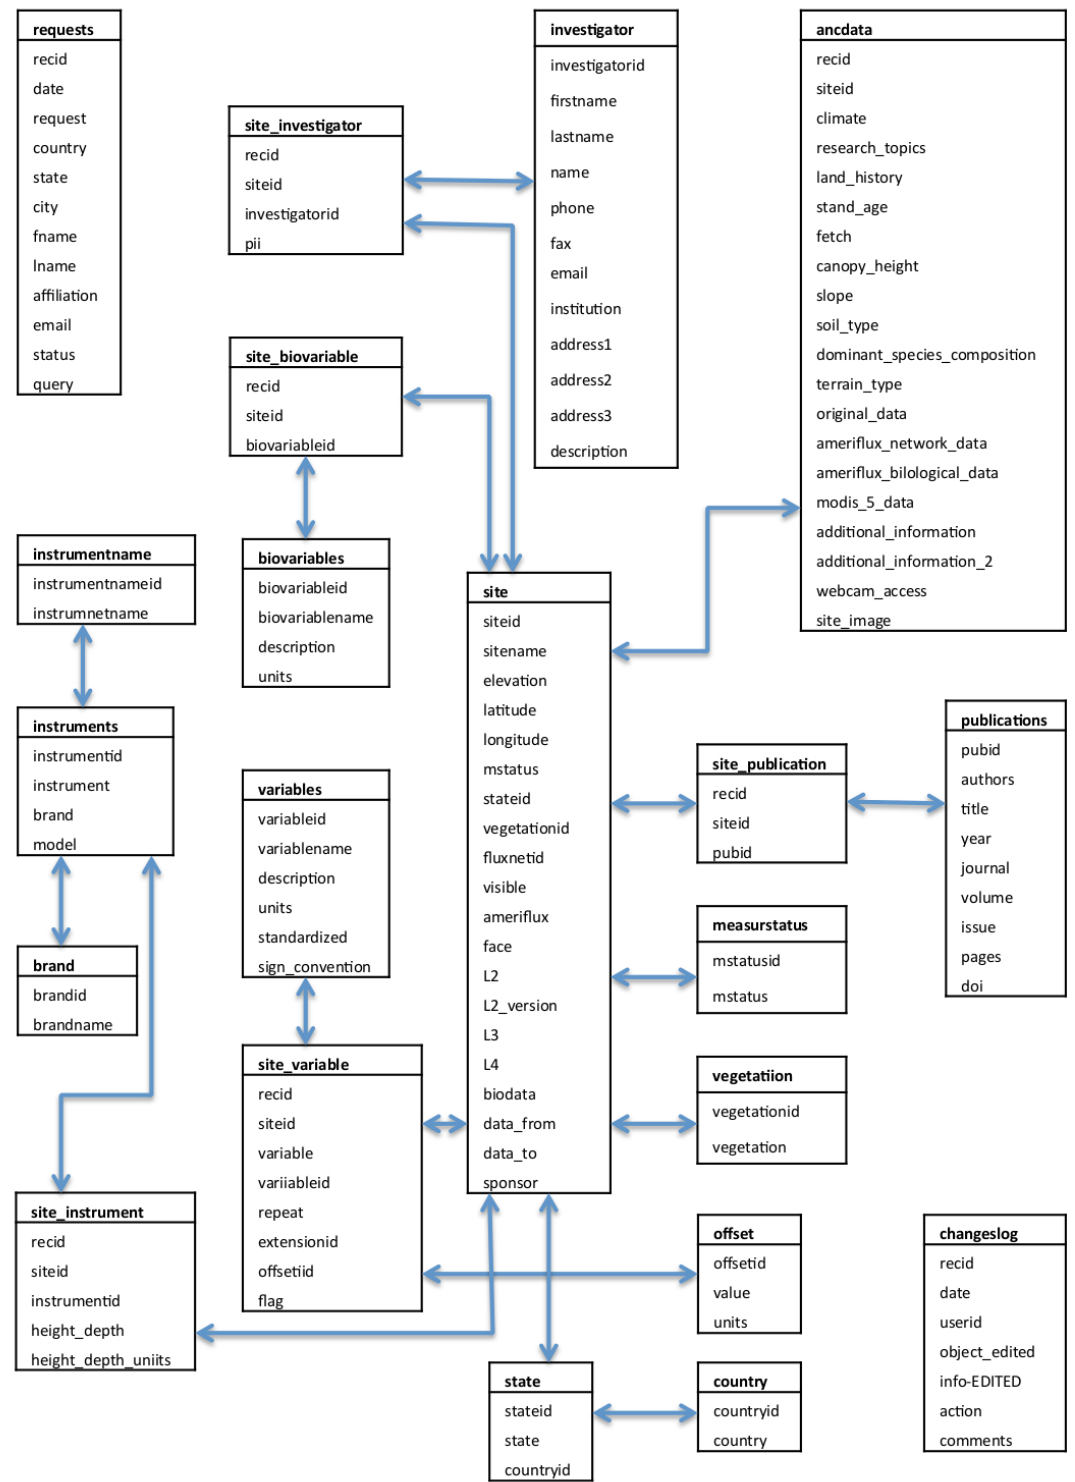
Fig. 6. Diagram identifying the tables comprising the CDIAC AmeriFlux MySQL relational database. Tables connected by arrows share two identical variables, the site identifier and site investigator, to enable queries across multiple tables. Tables not connected by arrows are stand-alone tables within the database. Table names are shown at the top of each table box in bold letters. Column names within each table are listed below the table